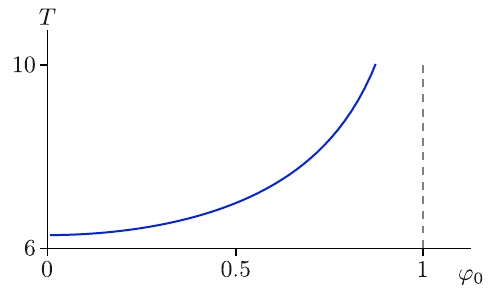
Figure A.3: The dependence of the elliptic sine period T in Eq. (A.17) on the value of the amplitude parameter ϕ . The period tends to infinity as the amplitude ap- 0 proaches